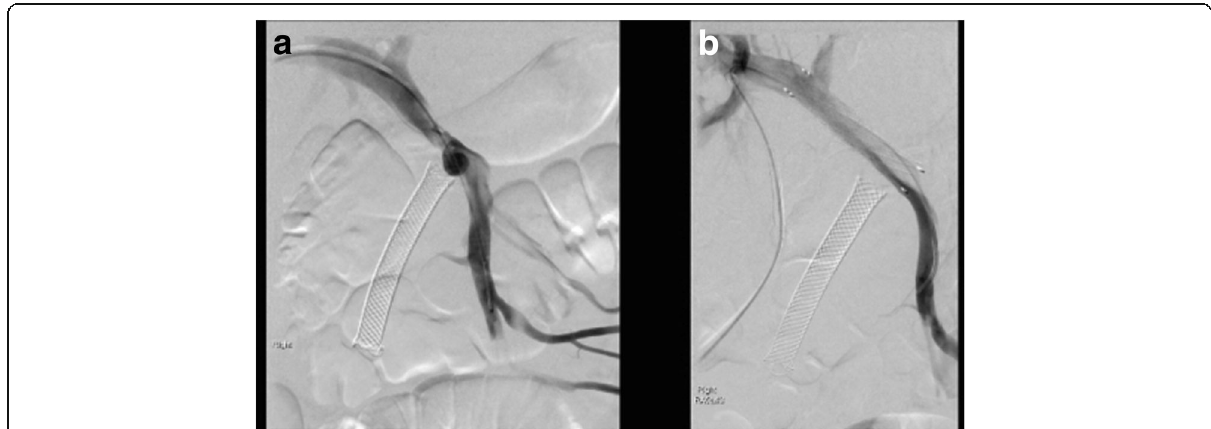
Fig. 4 Direct angiography of the pseudoaneursym pre and post-stenting. a Digital subtraction venogram showing a large portal vein